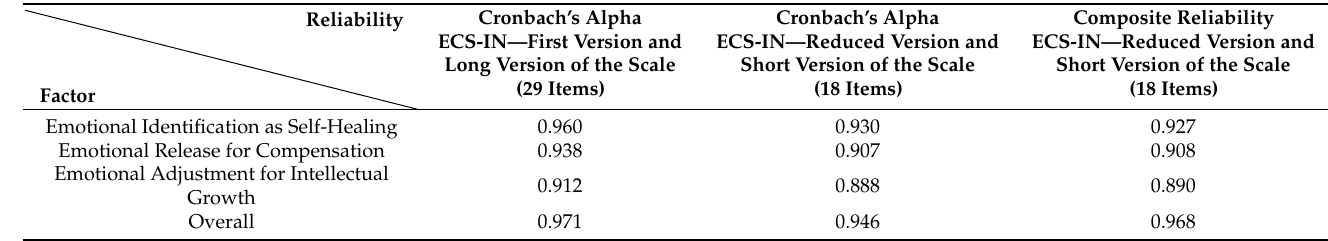
Table 4. Cronbach’s alphas and composite reliabilities of the first version (29 items) and the reduced version (18 items) of the ECS-IN.